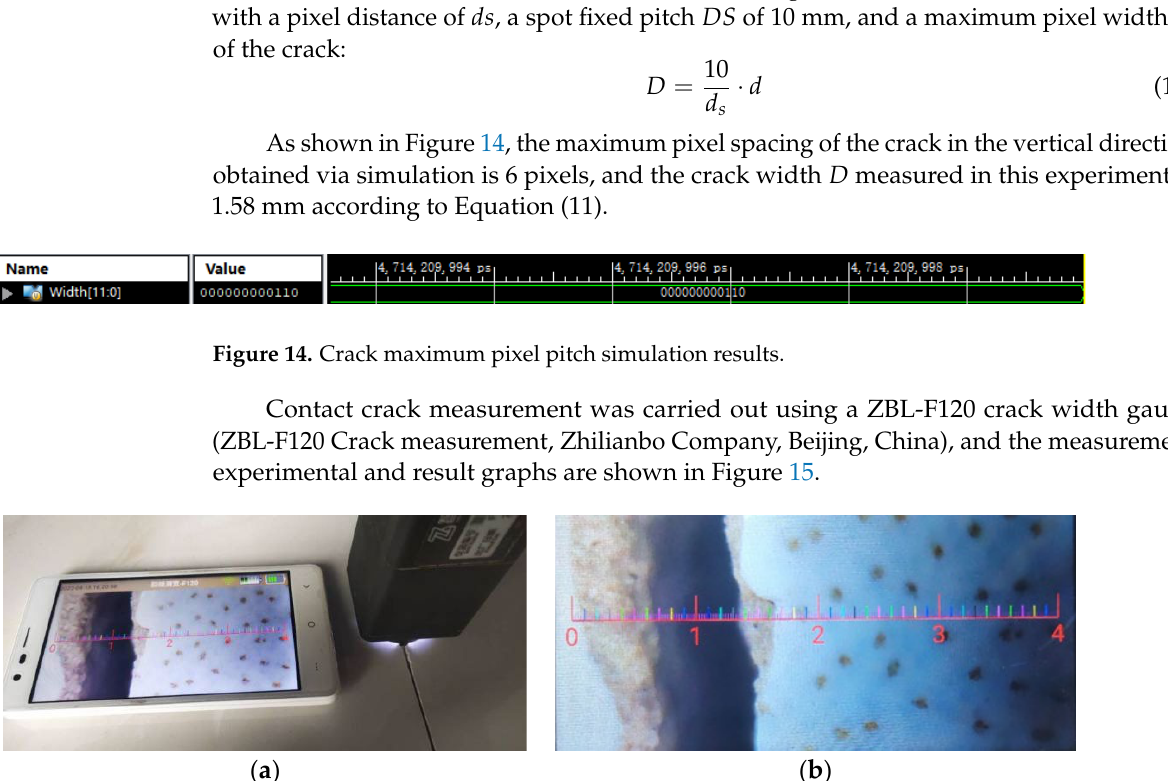
The comparison indicates an error between the FPGA simulation results and the